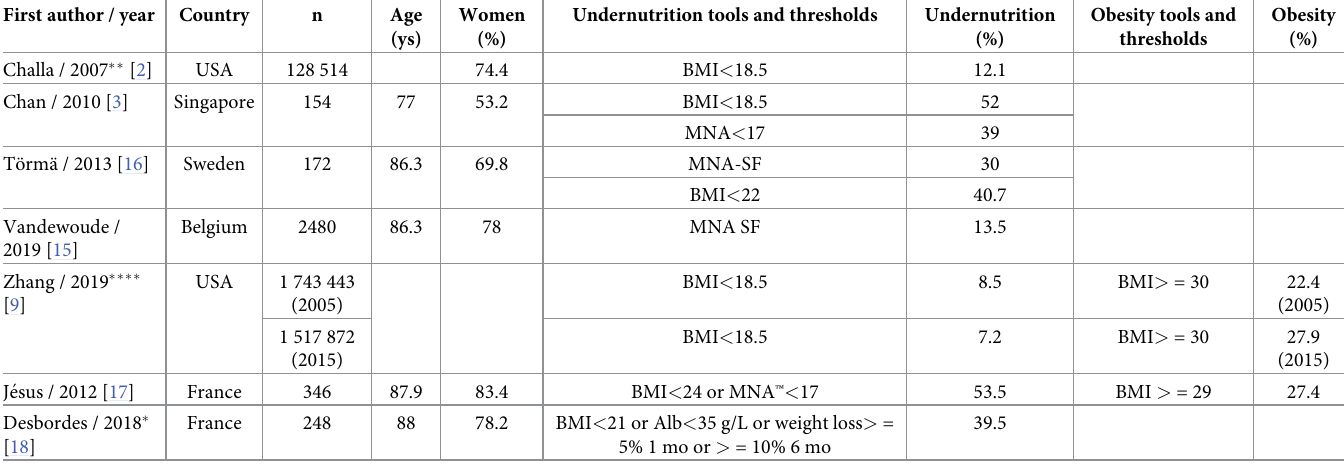
Table 1. Undernutrition and obesity among elderly in nursing homes in certain high-income